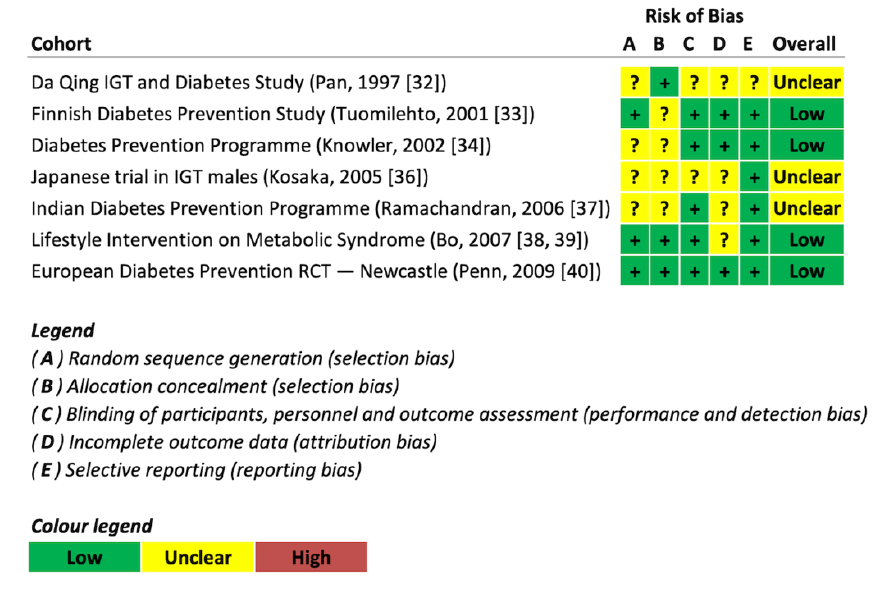
Figure 2. Risk of bias assessment.